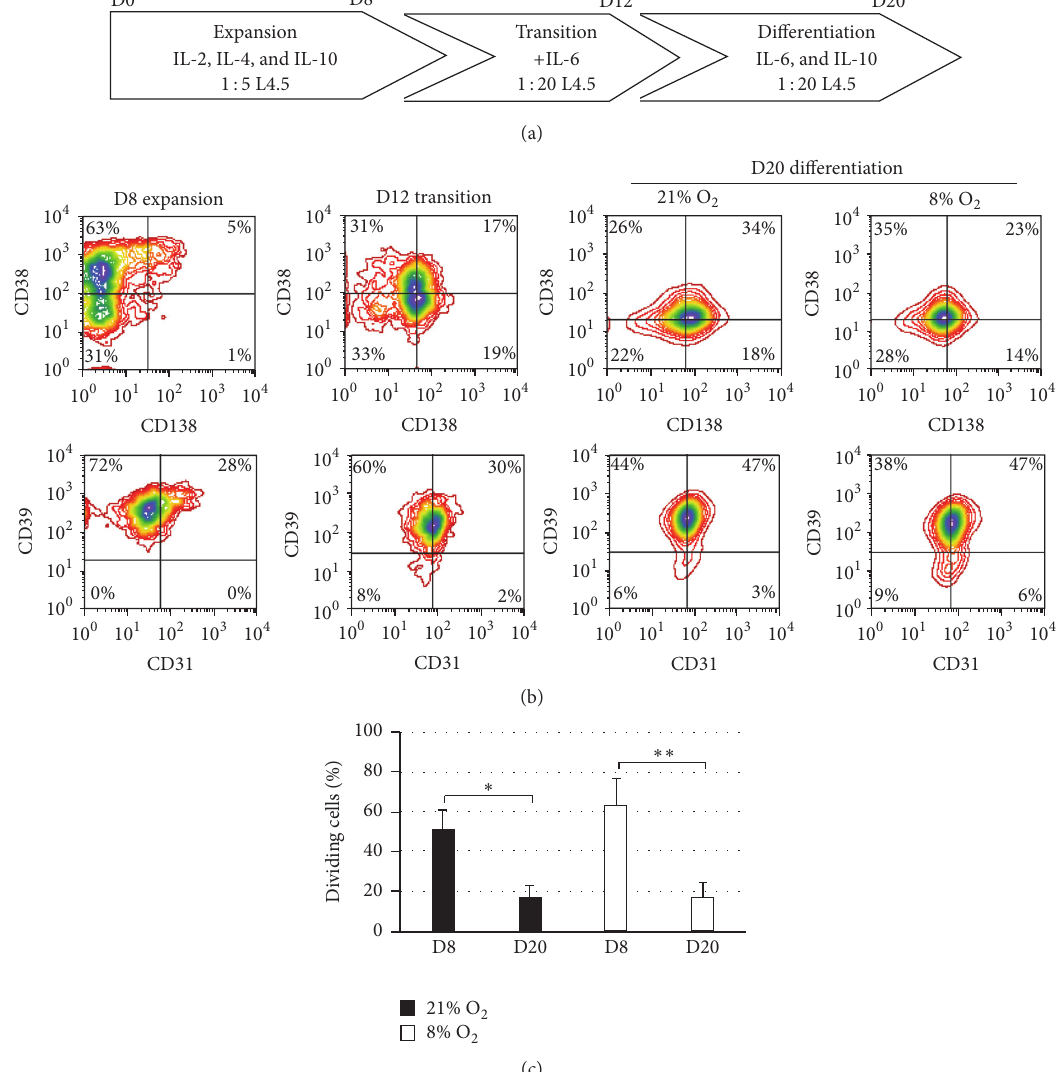
Figure 2: Differentiation profile of switched memory B cells under atmospheric and physiologic O 2 in BPFM medium. Switched memory B cells were subjected to a 3-step culture process (a). All cultures were done in BPFM. As illustrated in (a), the first 8 days of expansion were done asdescribedinFigure1.Afterwards,atransitionperiodoffourdayswasappliedtodecreasetheCD154interactiontoa1 : 20ratioandtoexpose B lymphocytes to IL-6. Finally, cells were maintained in the latter condition for an additional 8 days, except that IL-2 and IL-4 were removed from culture medium. During the differentiation phase, cells were subjected in parallel to 21% and 8% O 2 . (b) CD31, CD38, CD39, and CD138 expression were monitored at the end of each phase by gating on viable cells as shown in Figure 3(a). These results are representative of 5 independent experiments. (c) The effect of oxygen levels on cell cycle progression was studied in five additional independent samples cultured as previously mentioned, using the CellVue method. During the last four days of expansion and differentiation phases, cells were subjected to 21% or 8% O 2 in parallel; (c) show the proportion of dividing cells. Statistical analyses were done using the Dunn multiple comparison 𝑡 -test and the 𝑝 values are ∗ ≤ 0.05 and ∗∗ ≤ 0.01, as indicated. Data are presented as means ±